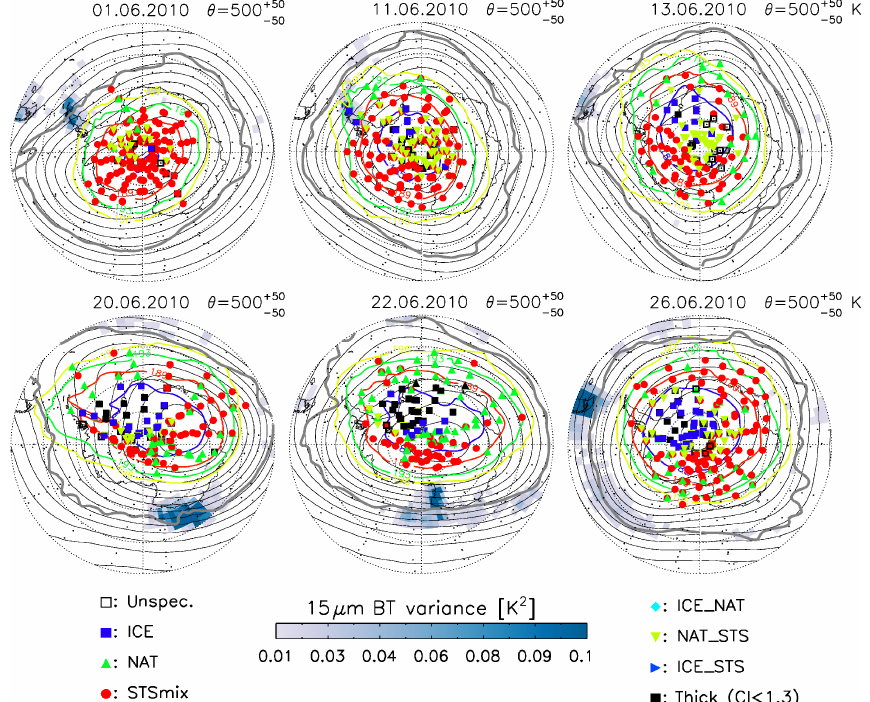
Figure 12. Coloured symbols represent daily PSC distribution of the Bayesian classifier for 1, 11, 13, 20, 22, and 26 June 2011 in the potential temperature altitude range 500K ± 50K equivalent to ∼ 20km geometric altitude. Black dots highlight the MIPAS profile location. Superimposed in colour-coded grid boxes with 4 ◦ longitude × 2 ◦ latitude resolution in the background show brightness temperature variances from AIRS as a proxy for GW activity in the lower stratosphere. Black contour lines represent the Montgomery stream function computed from ERA Interim (Dee et al., 2011) data and illustrate the large-scale geostrophic flow conditions. The potential vorticity-based vortex boundary is highlighted by a dark grey contour. In addition colour-coded temperature contours represent the existing threshold temperatures T NAT + 2K, T NAT , T STS (estimated by ( T NAT + T ice )/ 2), and T ice in yellow, green, red, and blue for constant stratospheric values for HNO 3 (9ppbv) and H 2 O (4ppmv) and according to the formula by Hanson and Mauersberger (1988) and Marti and Mauersberger